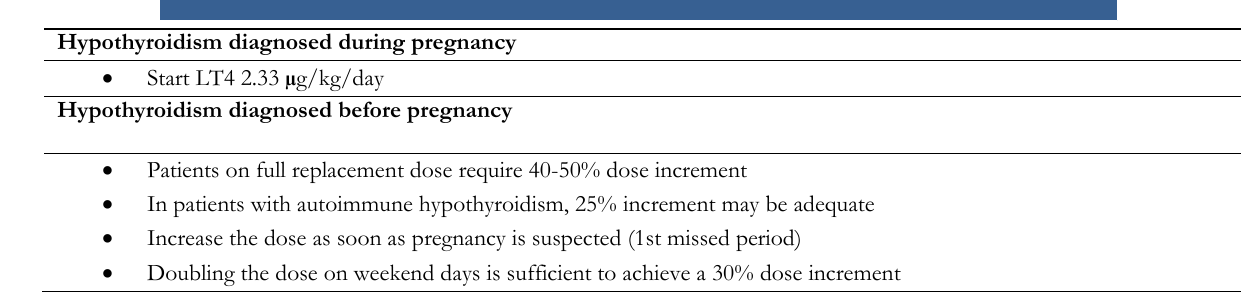
overt hypothyroidism in pregnancy. Table 4.4. Management of